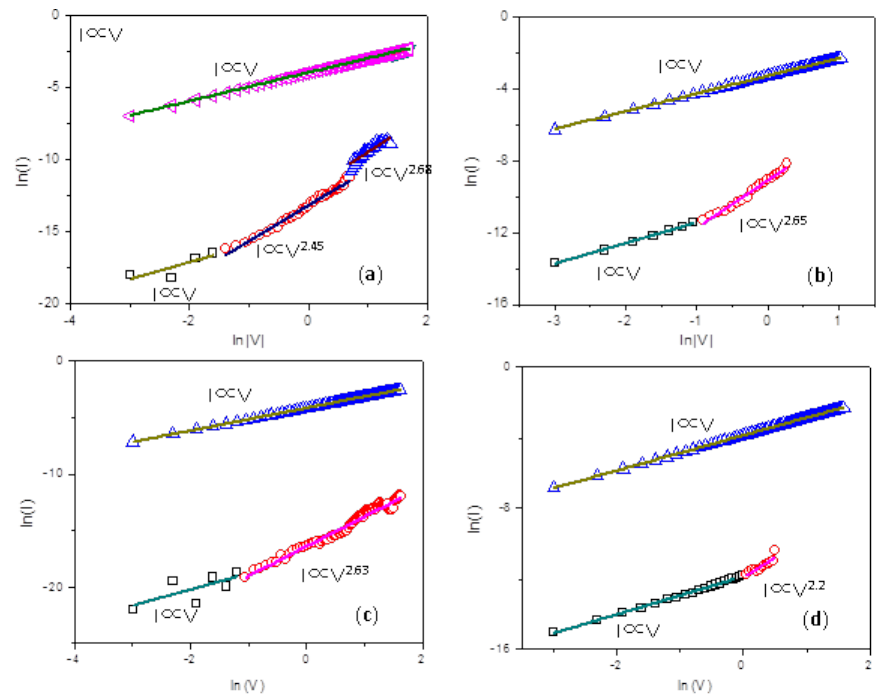
Figure 11. Linear fitting for I-V curve of on a log-log scale firstly during a negative voltage sweep for ( a ) Ni/PMMA: 1 wt % GO/ITO and ( b ) Ni/PMMA: 3 wt % GO/ITO; Linear fitting for the I - V curve of on a log-log scale during a positive voltage sweep for ( c ) Ni/PMMA: 1 wt % GO/ITO and ( d ) Ni/PMMA: 3 wt % GO/ITO.